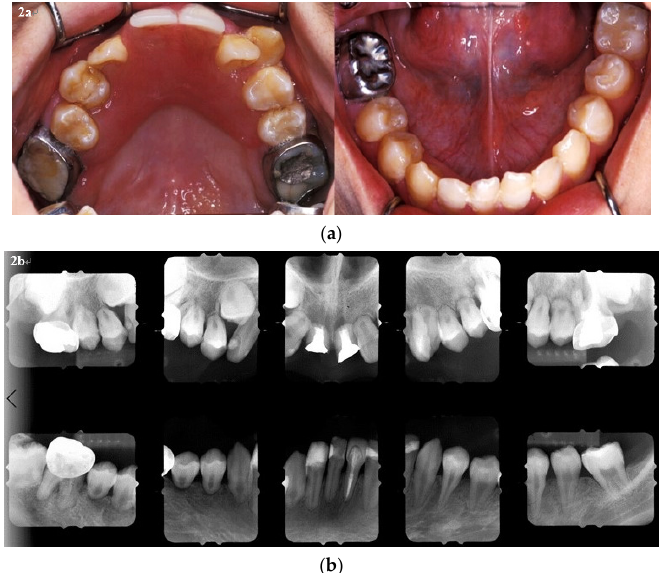
Figure 2. ( a ) The dental treatments performed included extraction, composite restorations, root canal fillings, stainless steel crown fabrication, banding, provisional restorations, and an interim denture. ( b ) Following root canal fillings, all new caries were restored, and the provisional prosthesis was